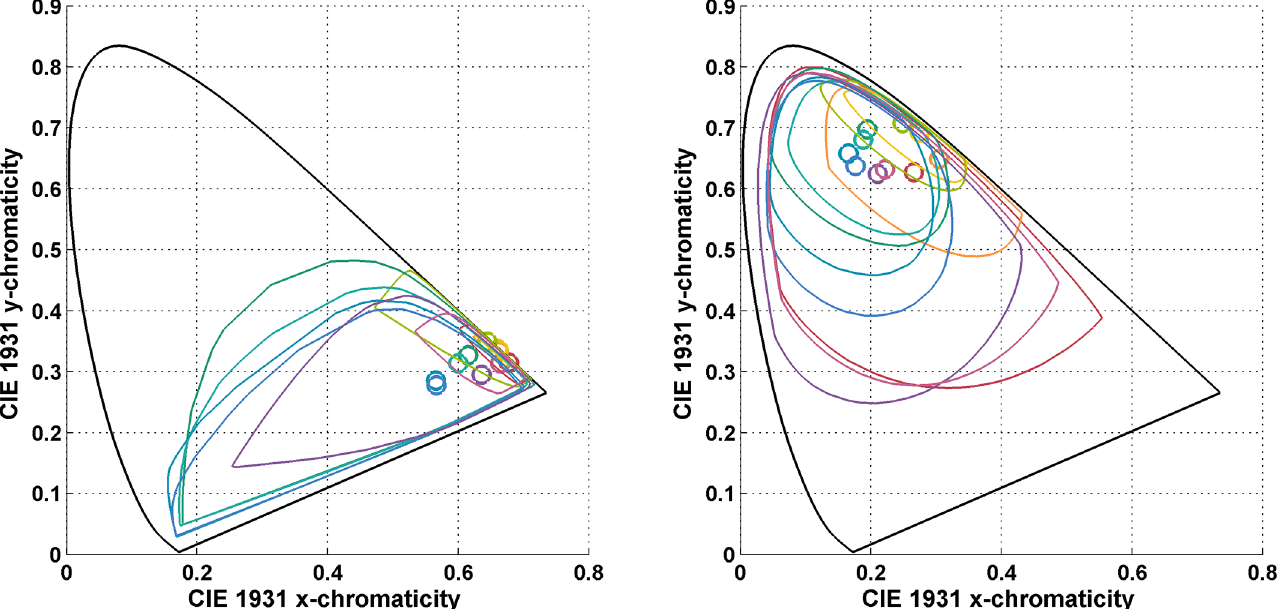
Fig 5. (Left) The chromaticity mismatch area for a shift from the neutral (N) to the red (R) illuminant. (Right) The chromaticity mismatch area for a shift from the neutral (N) to the green (G) illuminant. Plots are in the CIE 1931 xy-chromaticity diagram. The circles are the chromaticities of the 10 odd-numbered Munsell papers from Fig 2 (left) under the second illuminant in each case. The closed contours indicate the boundaries of the metamer mismatch areas. The colour of the circles and boundaries of the metamer mismatch areas correspond to one another, and very roughly indicate the colours of the Munsell